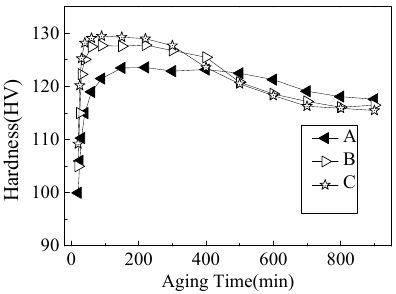
Figure 2. Vickers hardness evolution of the three alloys with ageing time at 170 °C immediately after quenching (error limit ±2%).